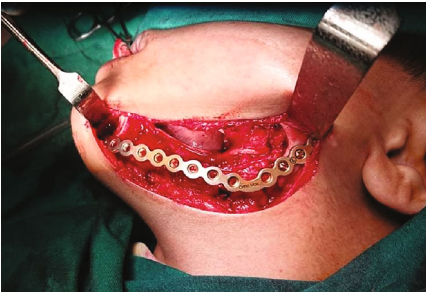
Figure 3: The titanium reconstruction plate.